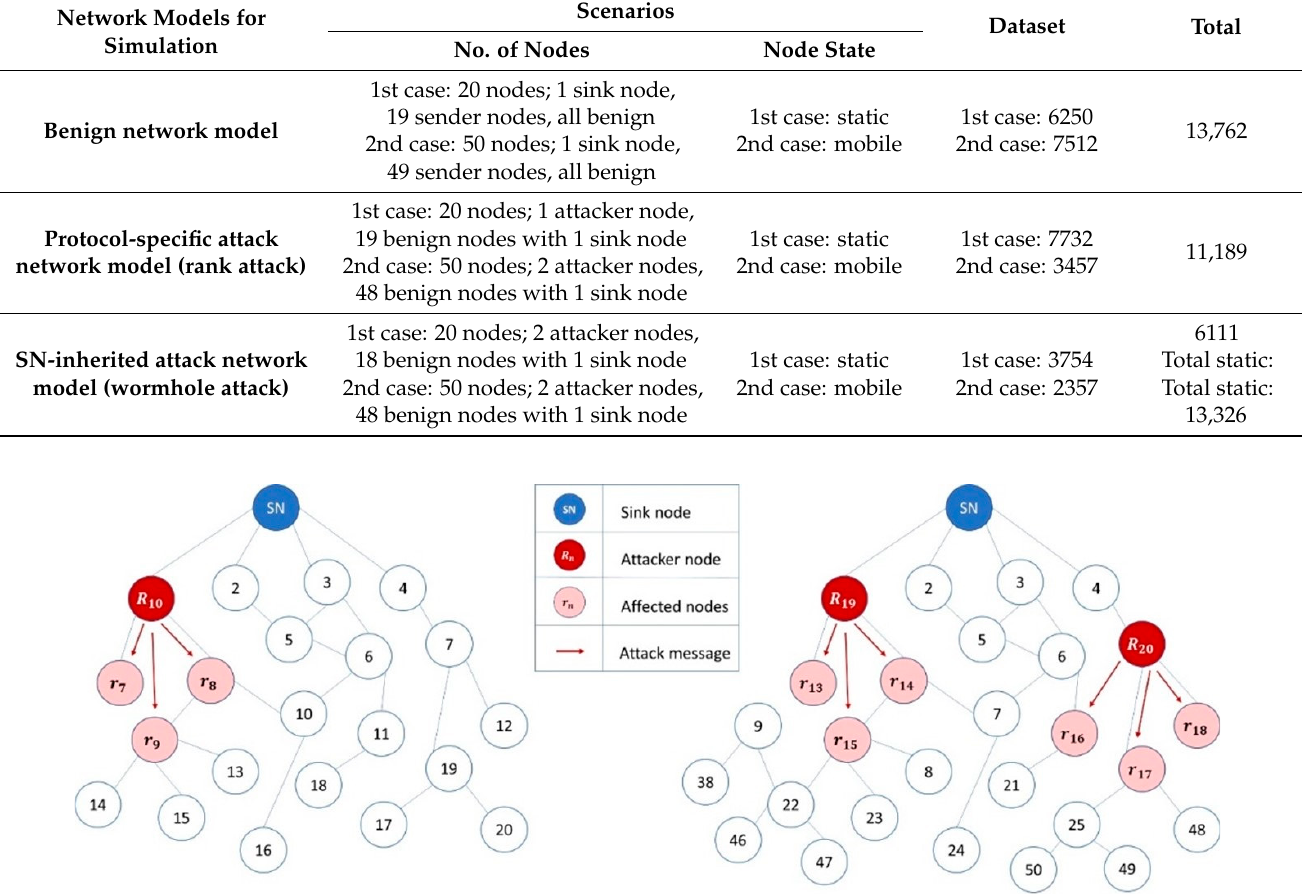
Figure 2. Protocol-specific attack simulation in RPL-based IoT networks simulated in Cooja. The attacker is located at position 10 in the left-hand side network, while two attackers are located at positions 19 and 20 in the right-hand side network.